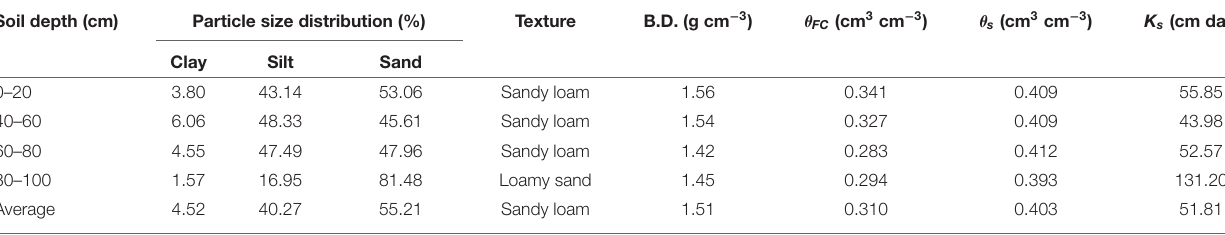
TABLE 1 | Physical and hydraulic parameters of the soil at the experimental station. Soil depth (cm)